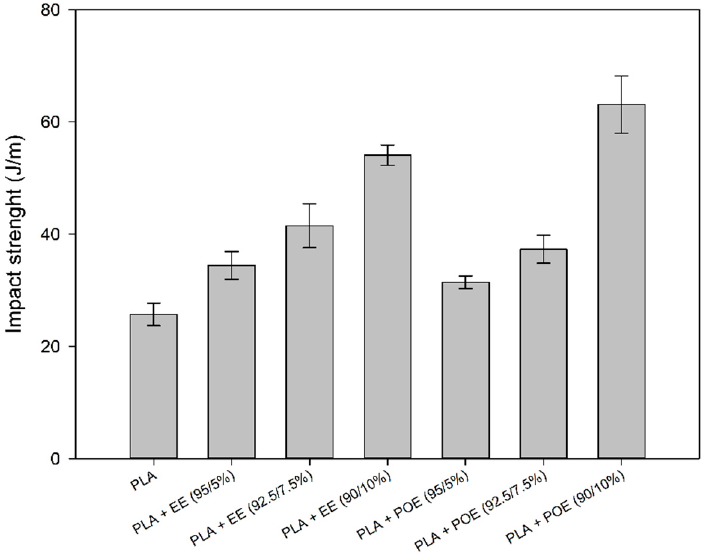
Figure 6. Impact strength of pure PLA and blends containing 5; 7.5 and 10% EE-g-GMA and POE- g-GMA.